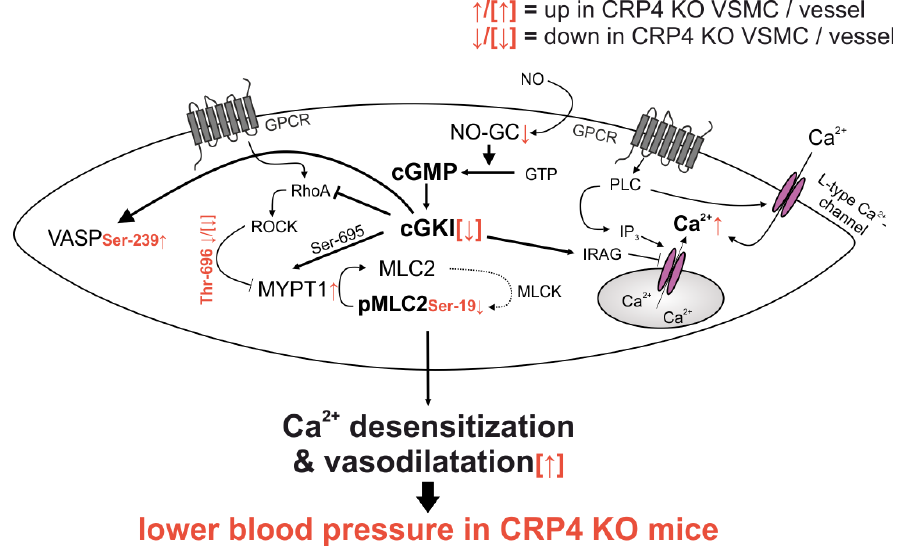
Figure 5. Synopsis of the altered signaling in CRP4 null VSMCs and vessels. Lack of CRP4 leads to discrete changes in total protein levels of NO-GC β 1 , cGKI, and MYPT1 and it causes alteration in the phosphorylation status of pVASP (Ser-239), pMYPT1 (Thr-696) and pMLC (Ser-19), which promotes the Ca 2+ desensitization of the contractile apparatus independently from the actual (Ca 2+ ) i concentration. Combined, these effects are indicative for a disinhibited activity of the NO-GC/cGKI pathway. This results in an improved vascular relaxation and lower BP in mice globally lacking CRP4 (further explanations are given in the main text).